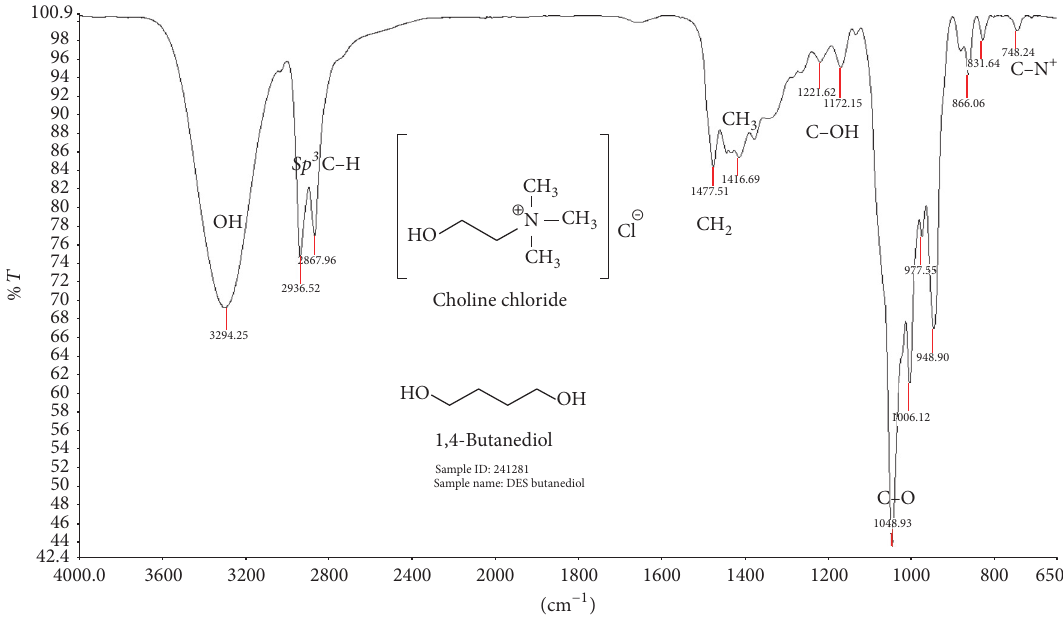
Figure 3: FTIR spectrum of alcohol-based